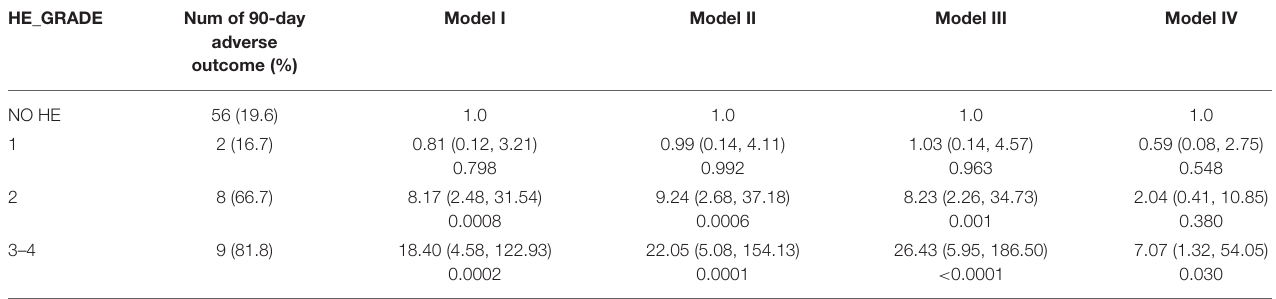
Model I, unadjusted. Model II, adjusted for age, sex, etiology. Model III, adjusted for model II plus ascites, infection, and gastrointestinal bleeding. Model IV, adjusted for model III plus total bilirubin, international normalized ratio, and